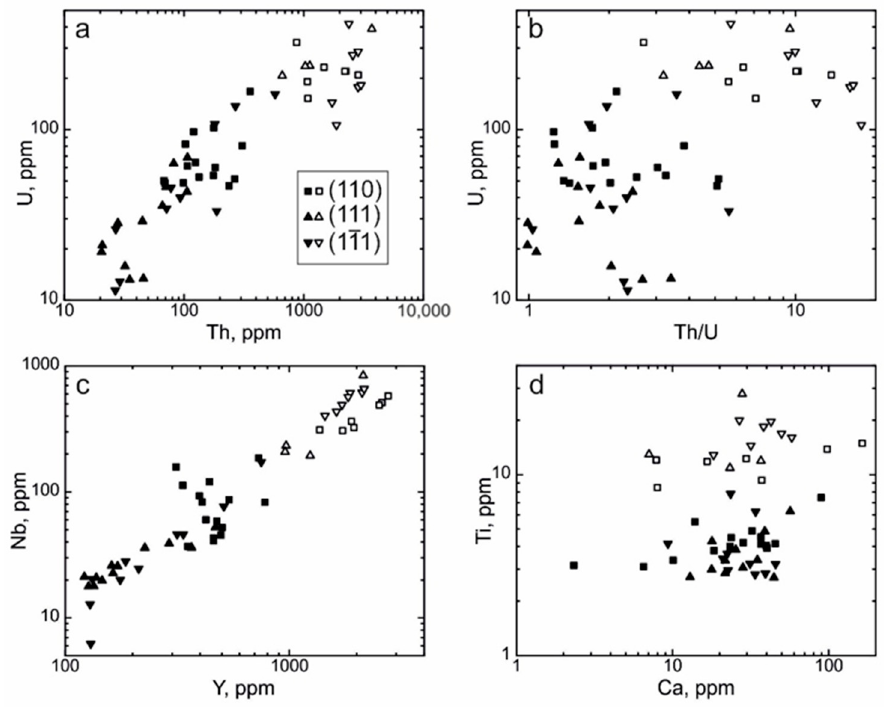
Figure 5. ( a ) Th versus U; ( b ) Th/U versus U; ( c ) Y versus Nb; ( d ) Ca versus Ti in